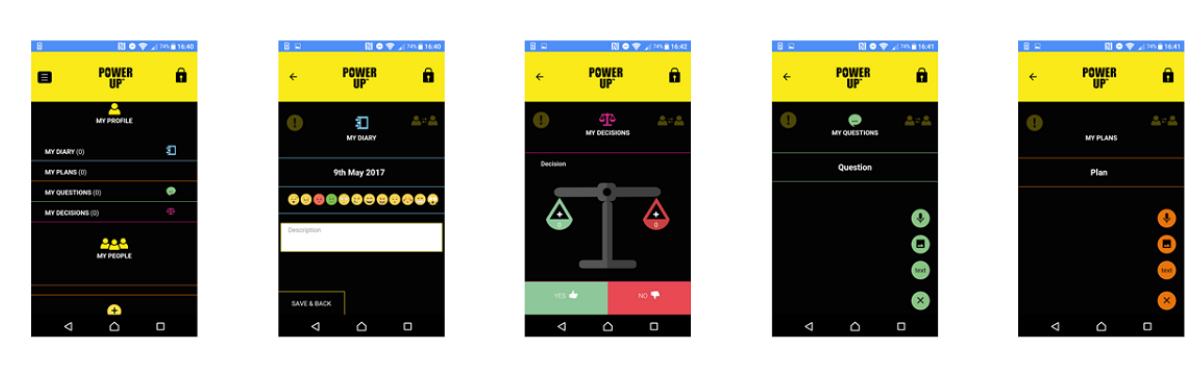
Figure 1. Power Up